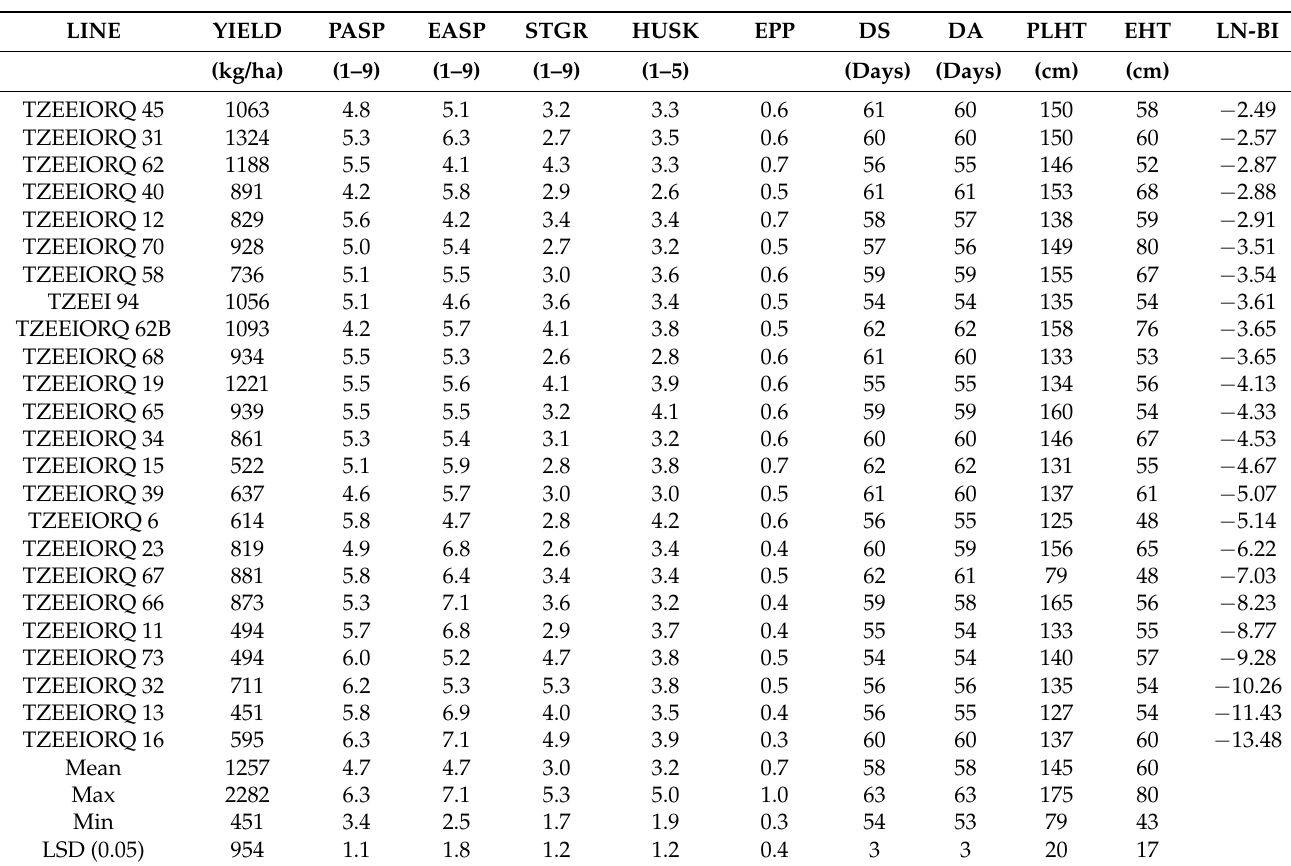
Averaged over inbred lines, grain yield was 1064 kg ha − 1 under Striga -infested envi- ronment, 1257 kg ha − 1 under low nitrogen and 2120 kg ha − 1 under high nitrogen; thus, compared to high nitrogen plots, grain yield reduction due to Striga and low nitrogen averaged 49.8% and 40.7%, respectively (Table 6). The number of ears per plant for these environments was 0.7, 0.7, and 0.8, respectively. Grain yield across the environments ranged from 658 kg ha − 1 for TZEEIORQ 16 to 2337 kg ha − 1 for TZEEIORQ 63 with an average of 1492 kg ha − 1 , while ears per plant ranged from 0.3 for TZEEIORQ 16 to 1.3 for TZEEIORQ 57 with a mean of 0.7. Ear aspect was lowest for TZEEIORQ 62 and TZEEIORQ 64 (3.2) and highest for TZEEIORQ16 (6.9) (Table 7). There were no significant differences in grain yield among the top five ranking inbreds (TZEEIORQ 57, TZEEIORQ 63, TZEEIORQ 42, TZEEIORQ 55, and TZEEIORQ 64), identified as resistant/tolerant to both Striga